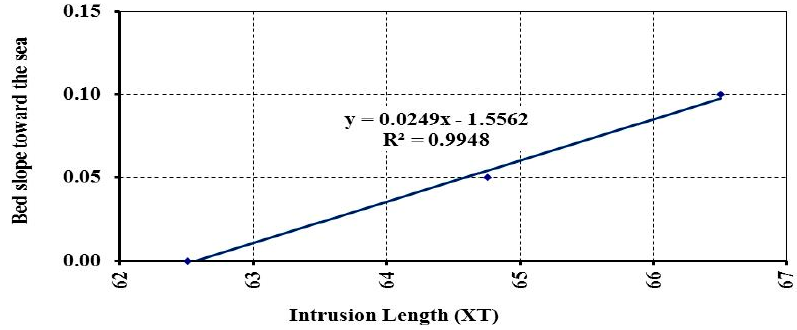
Figure 11. Relationship between bed slope toward the seaside and intrusion length (X T ) .